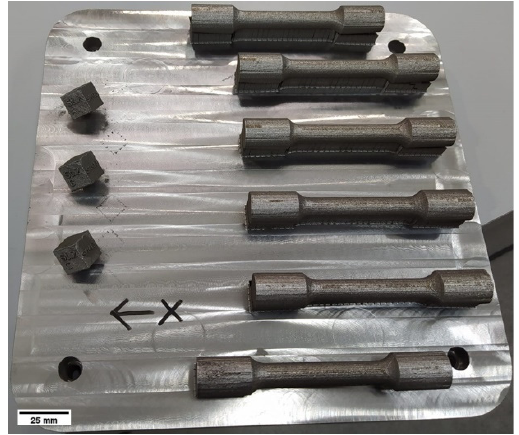
Figure 1. L-PBF build job of W-4130 steel showing the horizontal tensile specimens and the powder capsules.